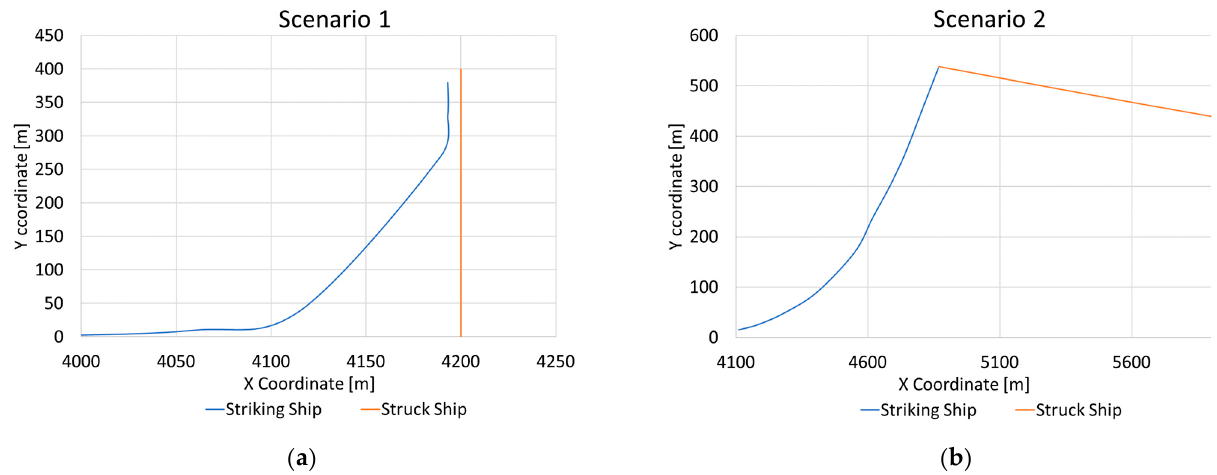
Figure 16. Coordinate tracking: ( a ) Scenario 1, ( b ) Scenario 2.